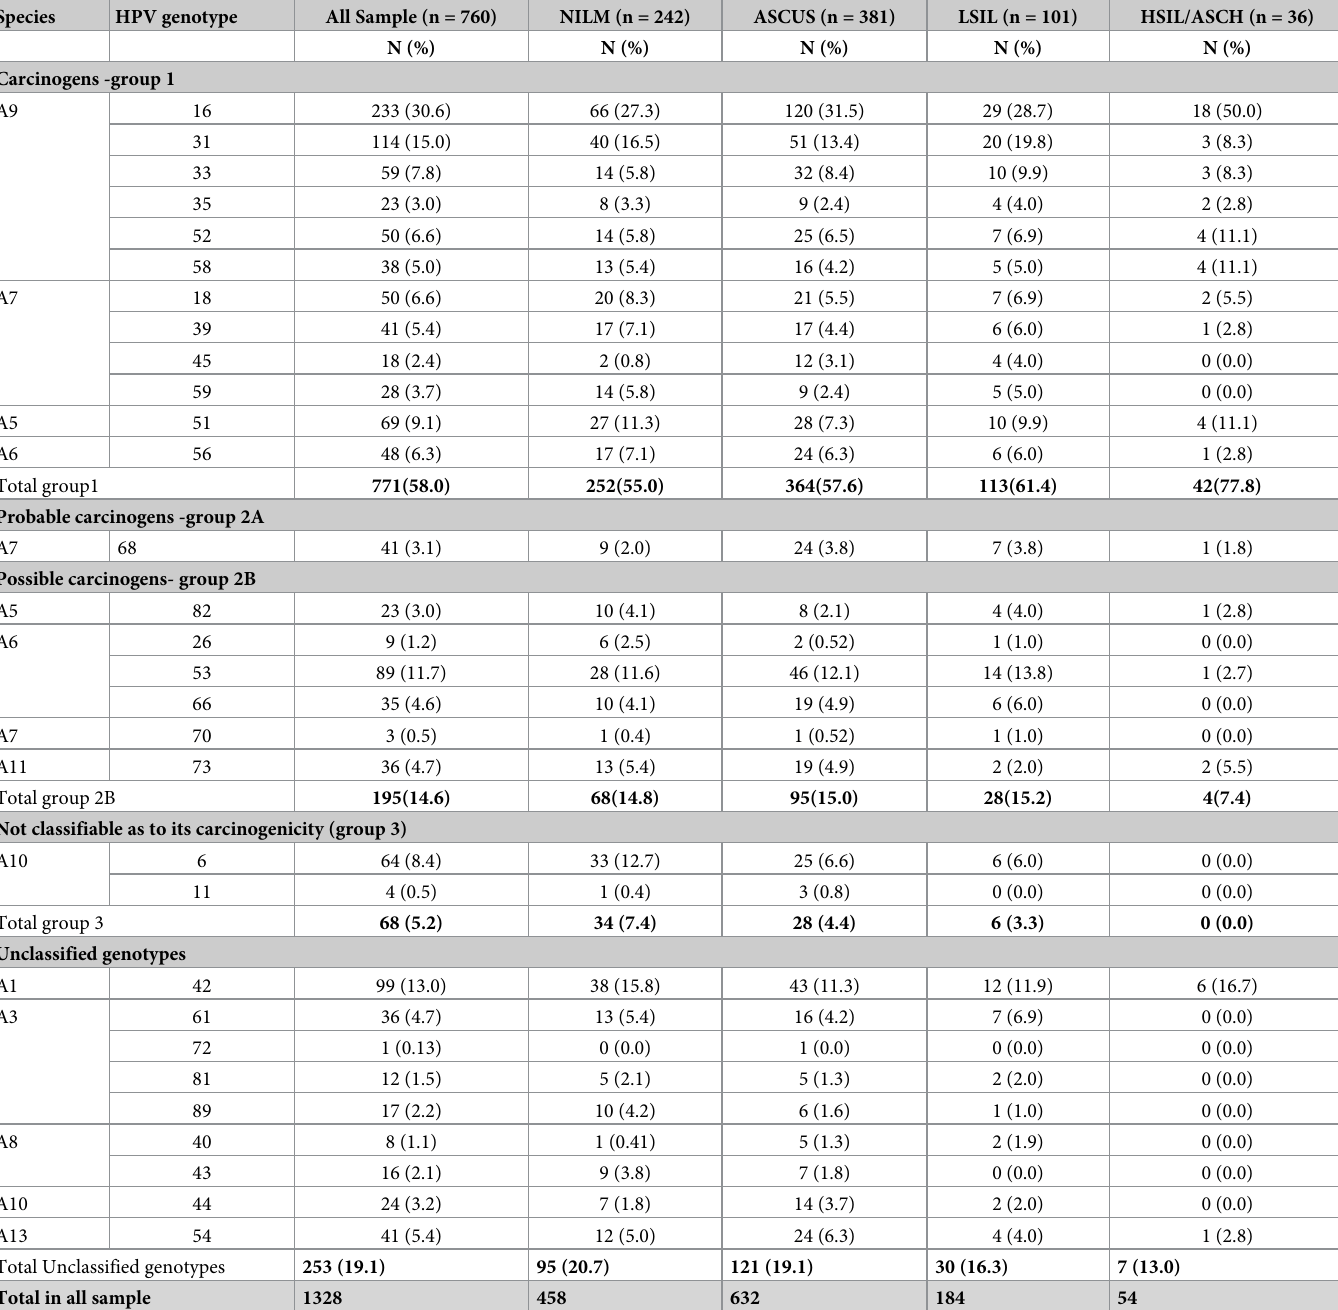
Table 3. The relationship between cytological diagnoses and Group 1, 2A, 2B, 3 and unclassified HPV genotypes among HPV positive